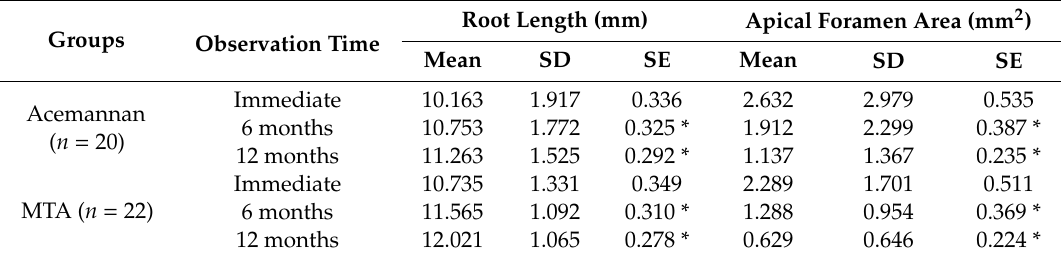
Table 1. The 3D radiographic root length and apical foramen area of the acemannan and MTA groups at baseline, 6- and 12-months post-treatment. The di ff erences in the root length and apical foramen area were analyzed using one-way